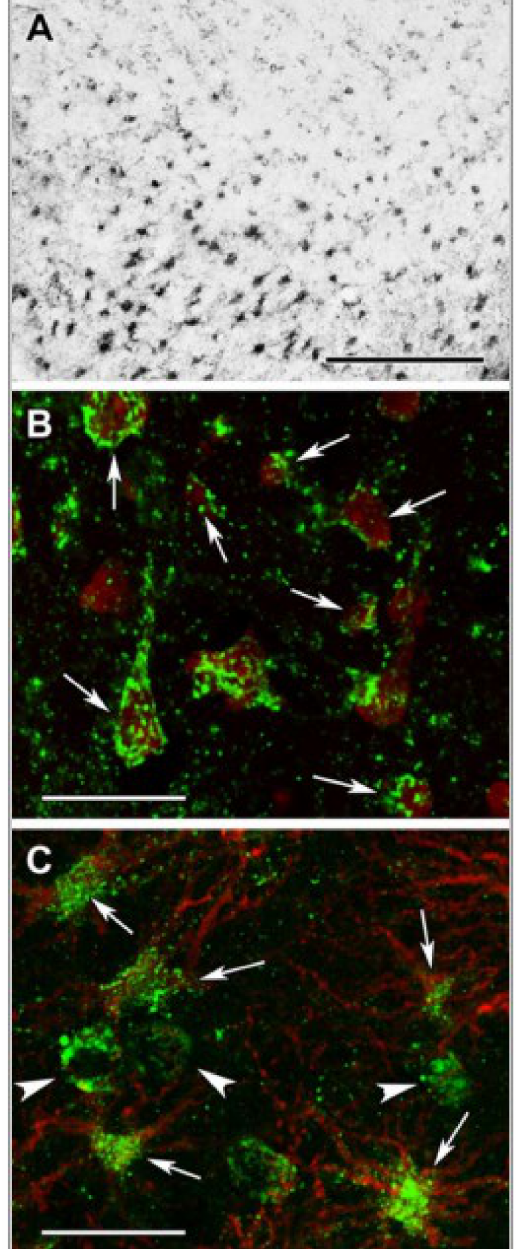
Figure 5. Succinyl-lysine immunolabeling in the human cerebral cortex in relation to neuronal and glial markers. ( A ): Succinyl-lysine-immunoreactive (SUCCLYS-ir) cells are present in the cerebral cortex, with higher density in the deep layers. ( B ): Succinyl-lysine (green) and fluorescent Nissl staining (red) show that essentially all cells (both neurons and glia) are double-labeled in the cerebral cortex. Arrows point to some of these double-labeled cells. Note the dot-like distribution of succinyl- lysine immunolabeling in the double-labeled cells. ( C ): A cerebral cortical section double-labeled with succinyl-lysine (green) and the established astrocyte marker glial fibrillary acidic protein (GFAP; red) to show the double-labeling of astrocytes. White arrowheads point to single-labeled (SUCCLYS-ir) neurons. Scale bars = 300 µ m for ( A ) and 30 µ m for ( B , C ). (Adapted from [100] under the terms of the Creative Commons CC BY